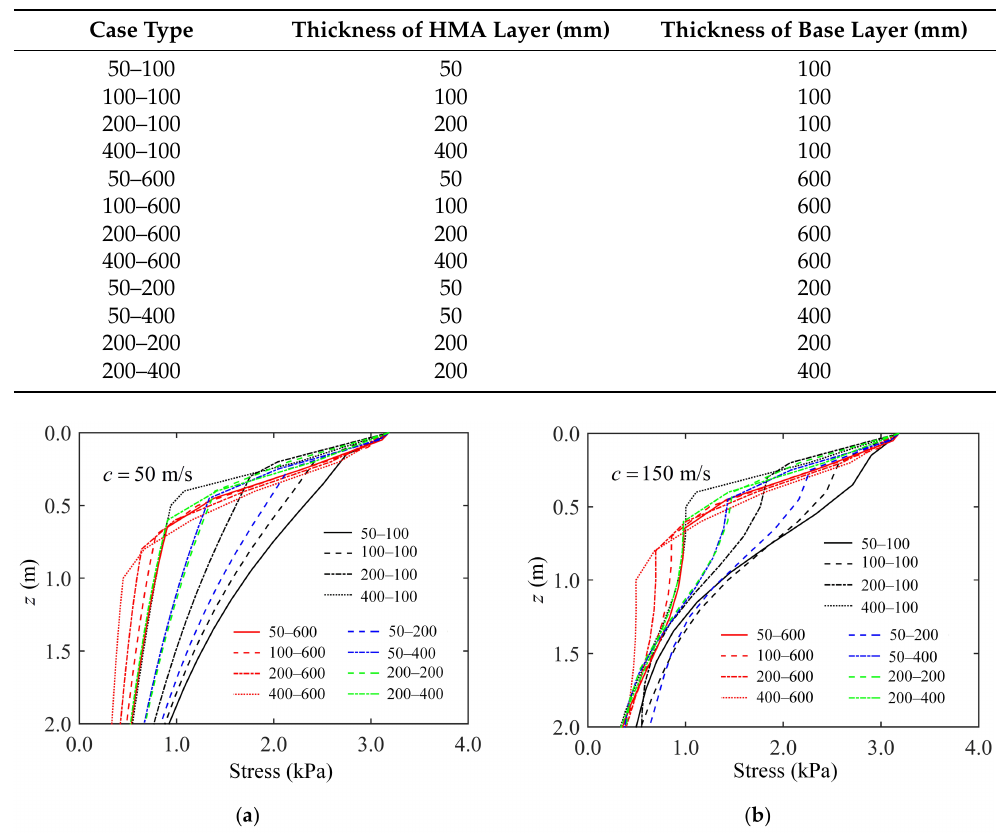
Table 3. Cases used for the analysis of the influence of variations in the layer thickness.